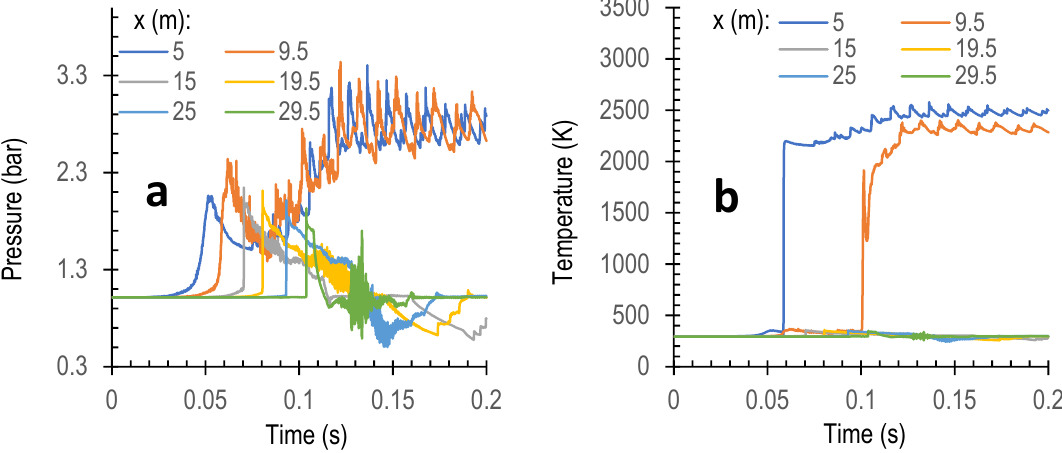
Figure 13. Local pressure ( a ) and temperature ( b ) monitored at different locations as a function of time in the scenario where the obstruction is completely inflated by the obstruction at the location x = 10 m.